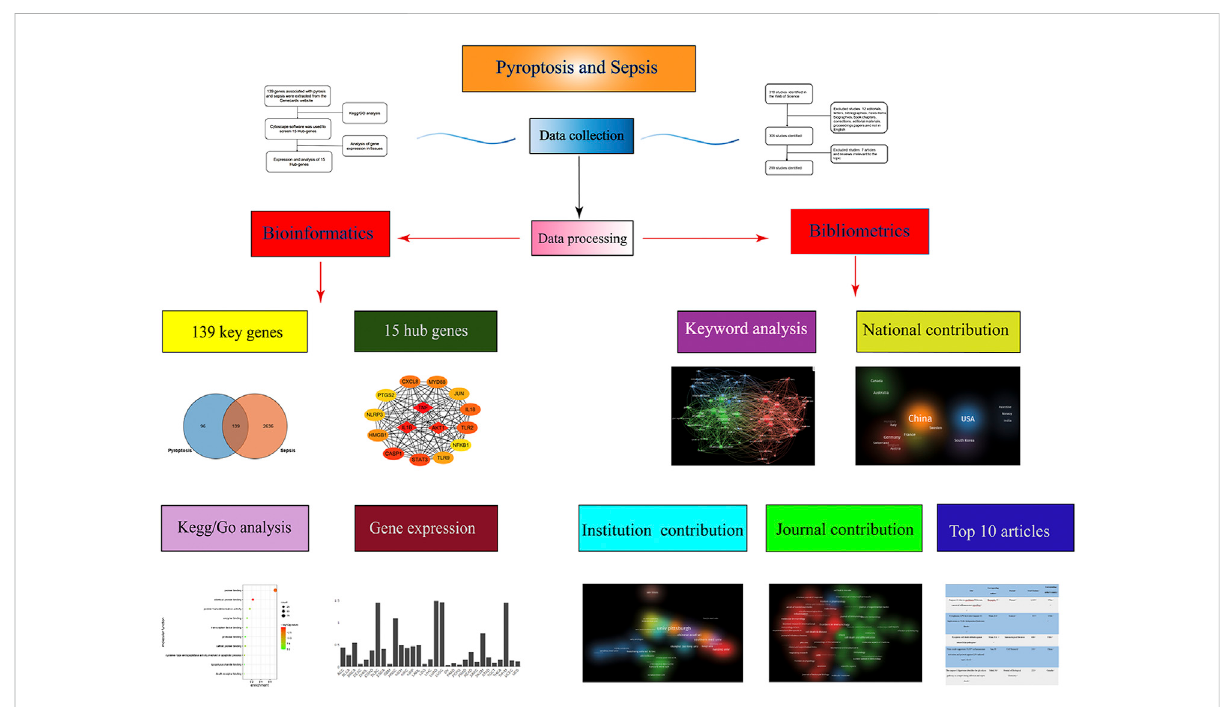
FIGURE 3 Bibliometrics and bioinformatics analysis fl ow chart of pyroptosis in sepsis